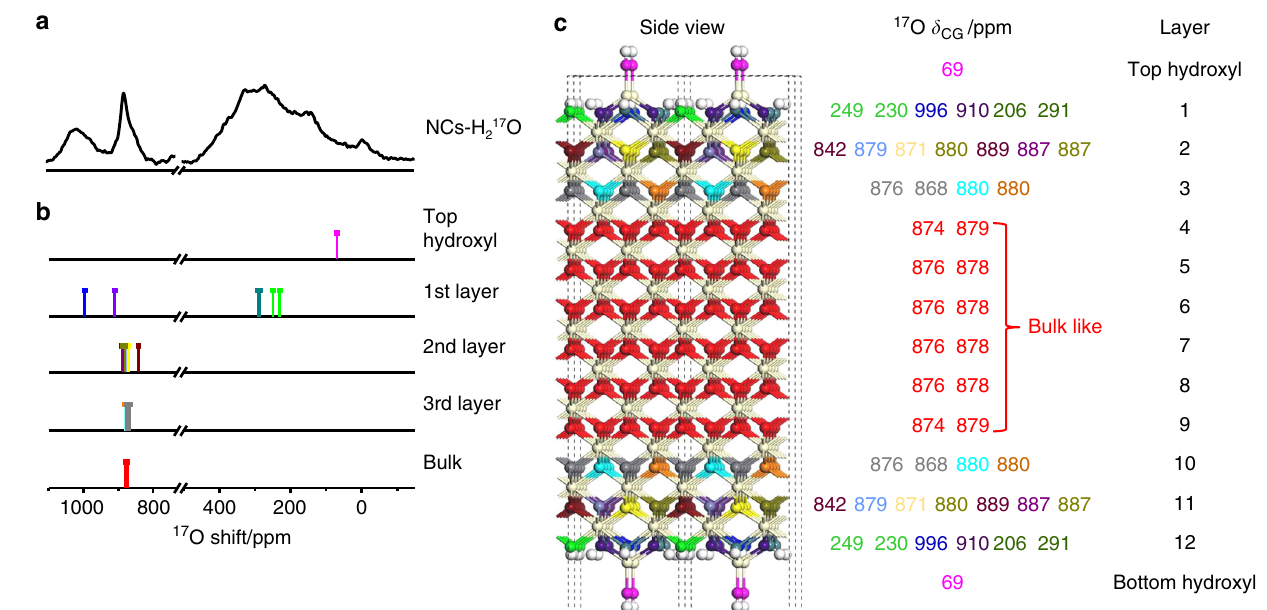
Fig. 5 17 O NMR spectrum, calculated 17 O NMR shifts and the structure model of ceria NCs-H 2 17 O. a 17 O Solid-State NMR spectra of ceria NCs-H 2 17 O (shown in Fig. 1). b The summarized 17 O NMR shifts ( δ CG s) predicted for the CeO 4 -t model with three H 2 O molecules dissociatively adsorbed on each surface unit (M 3 ). c The hydrated CeO 4 -t model used in the DFT calculations with calculated NMR shifts ( δ CG s) for oxygen ions and the layer number shown on the right. Red, off-white, and white balls represent bulk oxygen, cerium, and hydrogen ions, respectively. Surface oxygen ions with different shifts are shown in different colors. The calculated 17 O NMR parameters for each oxygen ion are shown in Supplementary Table